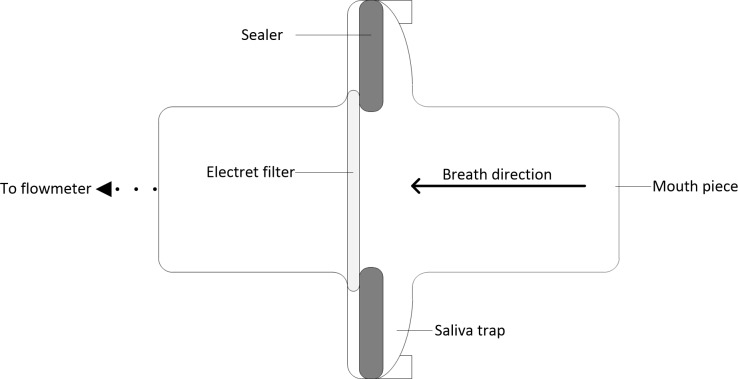
Schematic diagram of the designed collecting device in vertical section.